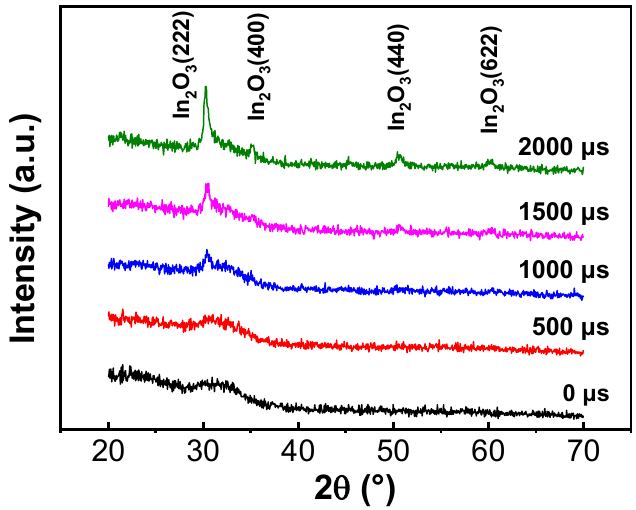
Figure 3. XRD patterns of ITZO films deposited at different pulse off-times.